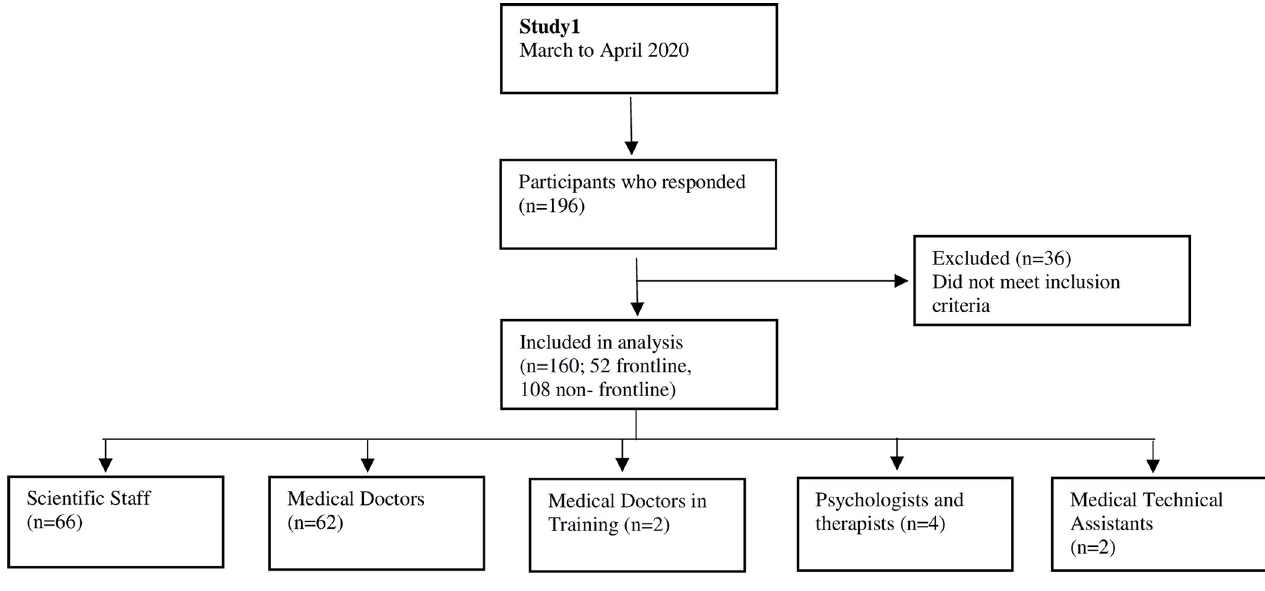
Fig 1. Flowchart of Study1 design and